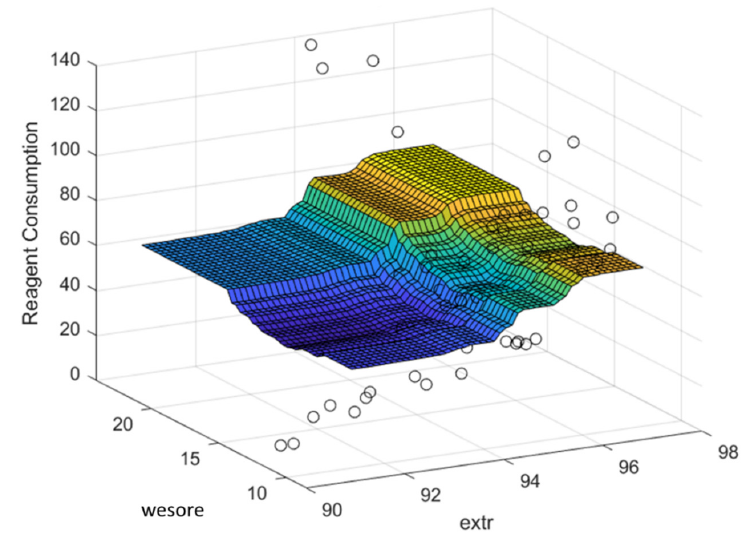
Figure 14. Bivariate partial dependence plot showing the effect of the two most influential variables, x 1 and x 5 , on reagent consumption. The observed data are indicated by ‘o’ markers.